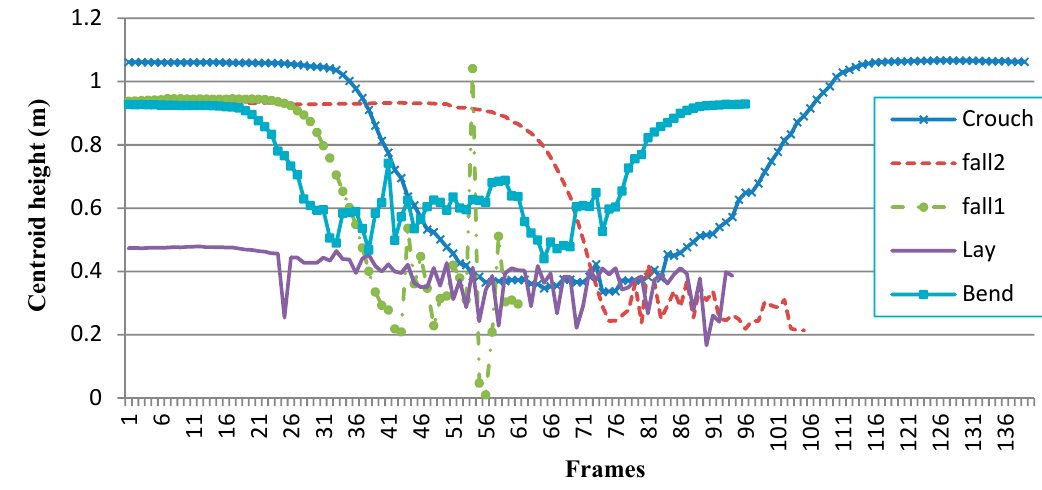
Figure 12. The centroid height changing curves of falsely judged samples.